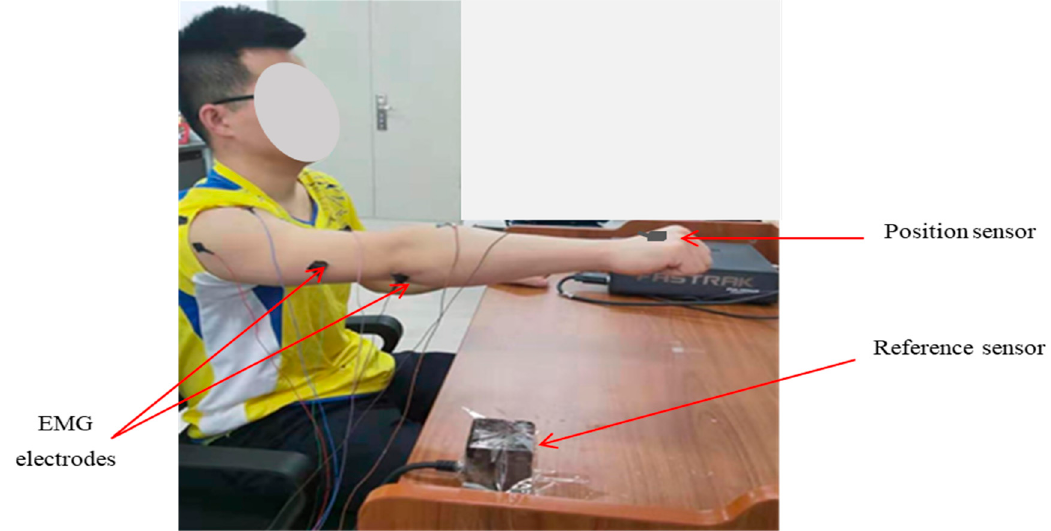
Figure 4. The experimental setup while the subject performs the required task.